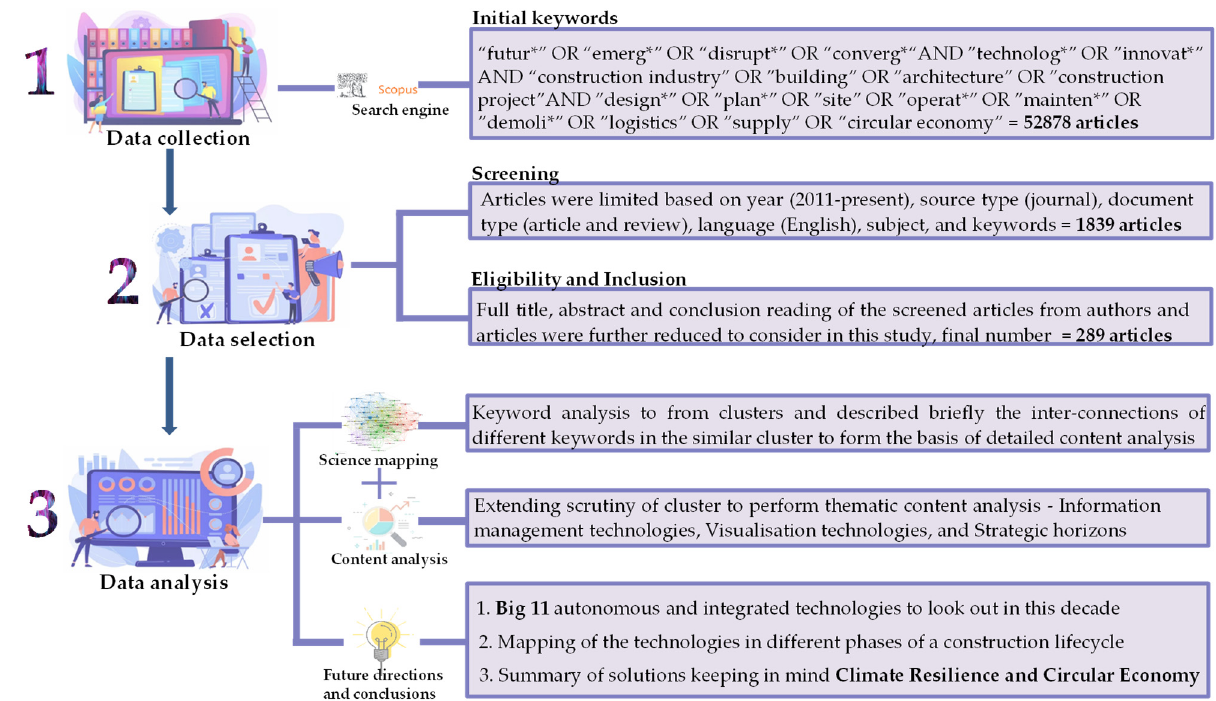
Figure 1. The multi-stage methodological framework for the study.